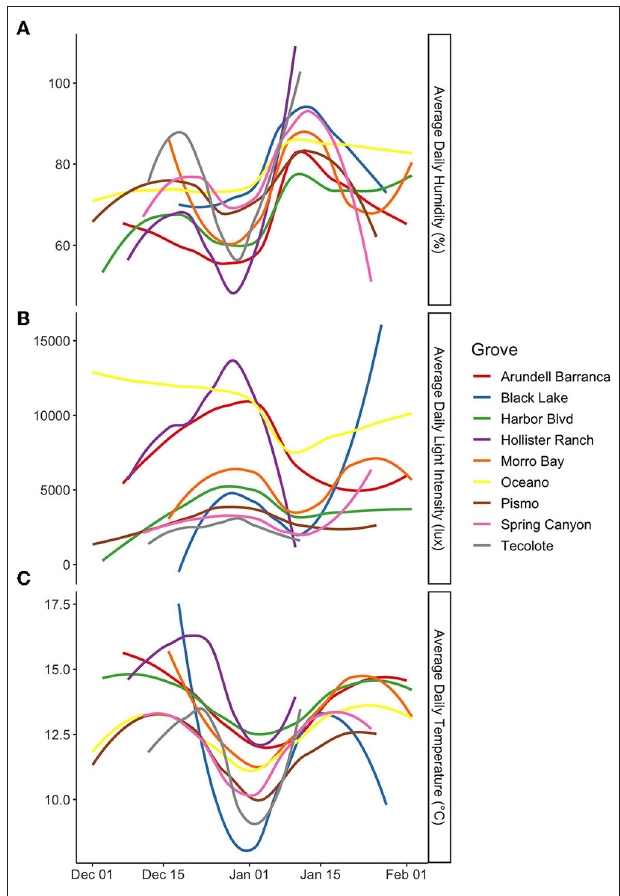
FIGURE 8 | Climate data for the interior of the groves in December and January of the 2018–2019 overwintering season for (A) average daily humidity (%), (B) average daily light intensity (lux), and (C) average daily temperature ( ◦ C). Lines have been smoothed to capture important patterns in the data and reduce noise. In an attempt to define uniform climatic attributes that occur in aggregation locations across the groves, instead, we find that the aggregation locations are no more uniform than the other parts of the groves, and that taken collectively, the insides of the groves are quite